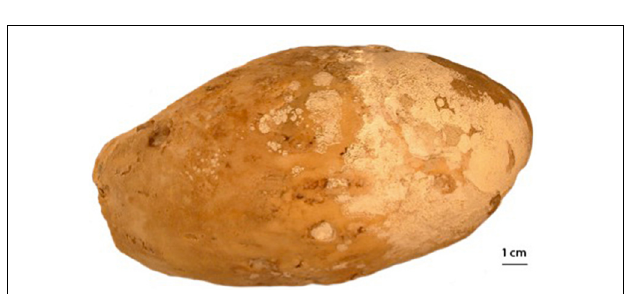
FIGURE 3 | Largest vaginal calculi observed (collection number